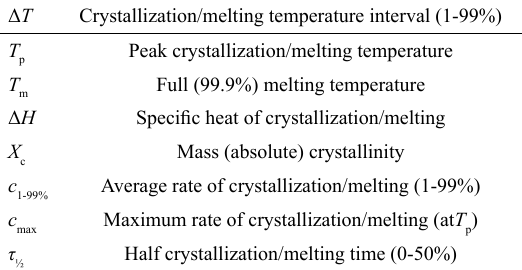
Table 2. Definition of crystallization/melting parameters reported in Tables 3 and 4 Δ T Crystallization/melting temperature interval (1-99%)